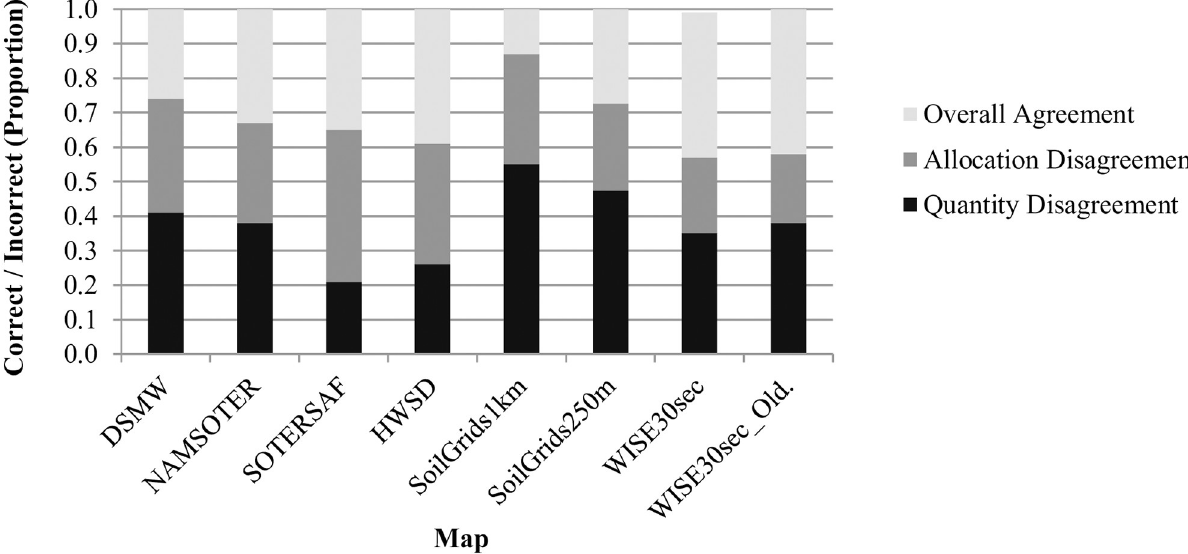
Fig 5. Overall agreement and disagreement between map and field data. See the section on “Topsoil Texture Map Accuracy Assessment” for a definition of overall agreement and disagreement. See the text for full names and versions of the map data sources.